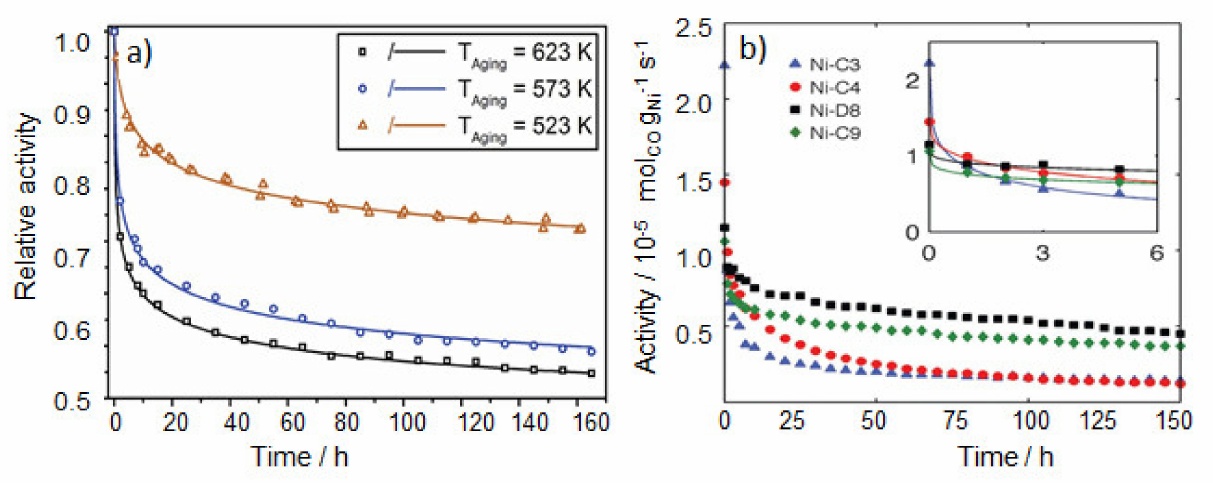
Figure 3. ( a ) Time-on-stream change of relative activity of NiAlO x catalyst (Ni:Al ratio of 3:1) during CO 2 reduction (H 2 /CO 2 /Ar/N 2 = 8/2/9/1) gas mixture at ambient pressure at three different temperatures. Catalytic activity measurements were done using 50 mg of the catalyst diluted by 450 mg of SiC using a total gas flow of 500 mL min − 1 . Relative activity is defined as the activity on stream normalized to the initial activity (reprinted with permission from Ref [40] © 2019, Elsevier Inc, Amsterdam, The Netherlands). ( b ) Time-on-stream change of the Ni-mass normalized activity of CO reduction (H 2 /CO = 2:1) at 230 ◦ C on Ni/SiO 2 catalysts with different initial particle sizes of NiO/Ni (Ni-D8: 7.7/7.5 nm; Ni-C9:8.7/9 nm; Ni-C4: 3.9/4.3; Ni-C3: 3.2/3.2 nm). Measurements were carried out on a powder mixture of 10 mg of Ni/SiO 2 catalyst and 200 mg of SiC and a total gas flow of 6 Nml (STP) min − 1 resulting in GHSV of 18,000 h − 1 (reprinted from Ref [41] © 2014, Wiley Inc (Hoboken, NJ,